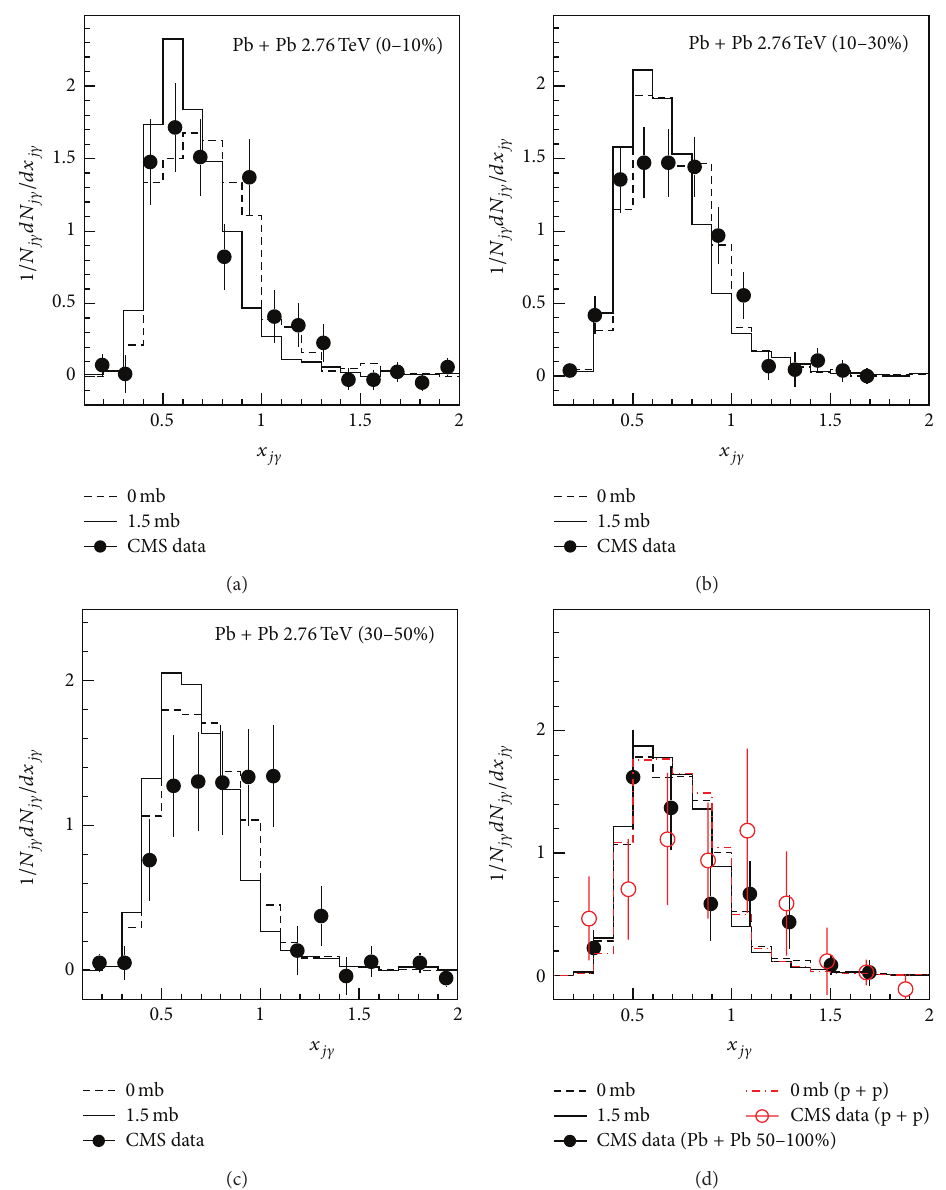
𝛾 𝑝 𝛾 > 60 GeV/c) and jet ( 𝑝 jet > 30 GeV/c, Δ𝜙 > 7𝜋/8 ) 𝑗𝛾 𝑇 between the photon ( 𝑇 𝑇